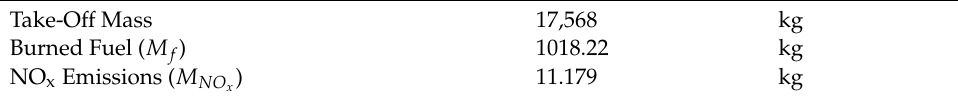
Table 6. Baseline reference